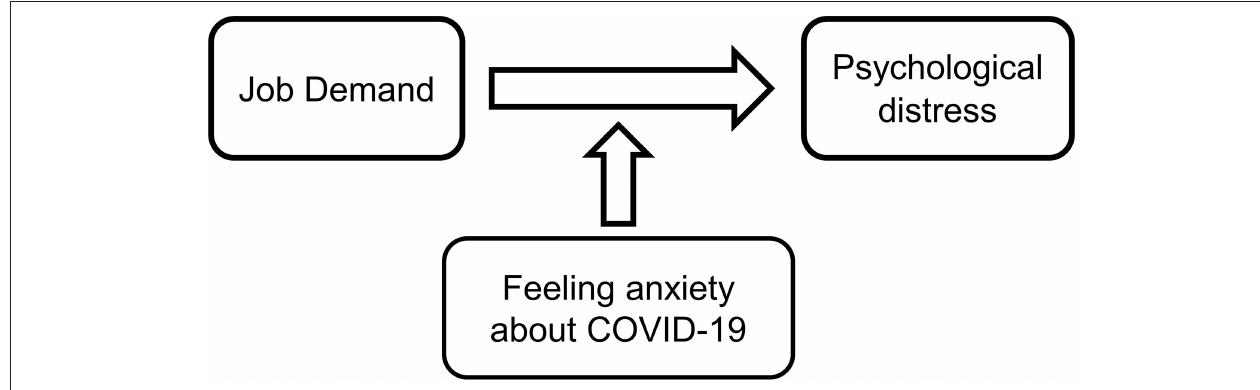
FIGURE 1 | Conceptual model of possible associations between felt anxiety about COVID-19, job demand, and psychological